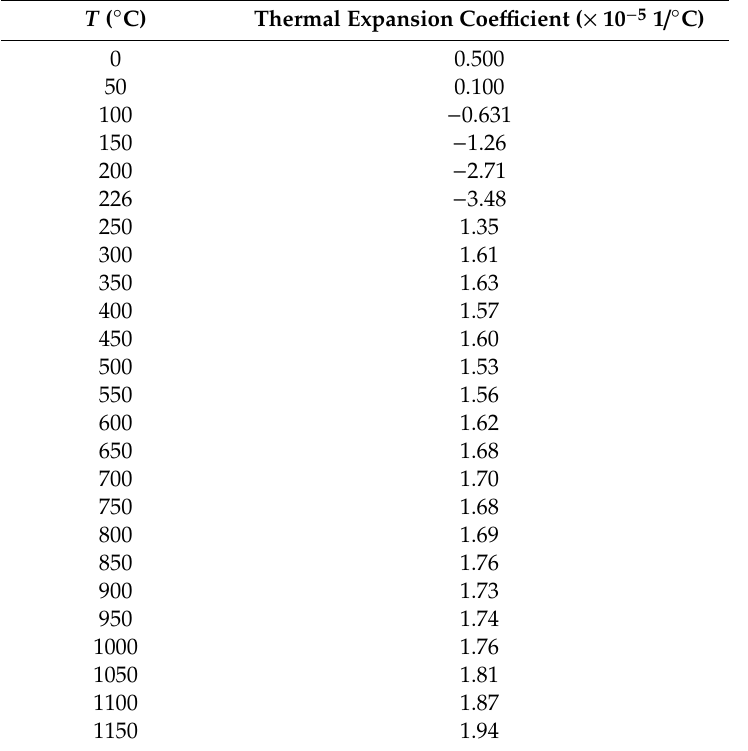
Table A2. Thermal expansion coe ffi cient for M4 HSS material obtained by DED process.